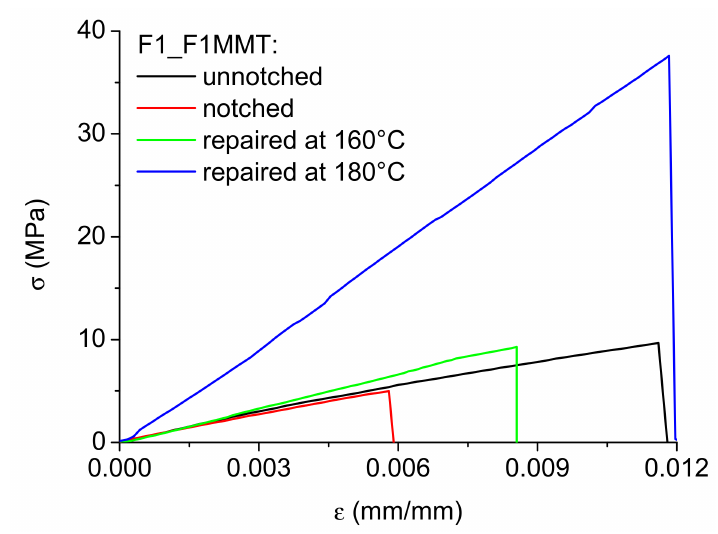
Figure 7. Flexural stress–strain curves on PBT nanocomposites before and after healing.